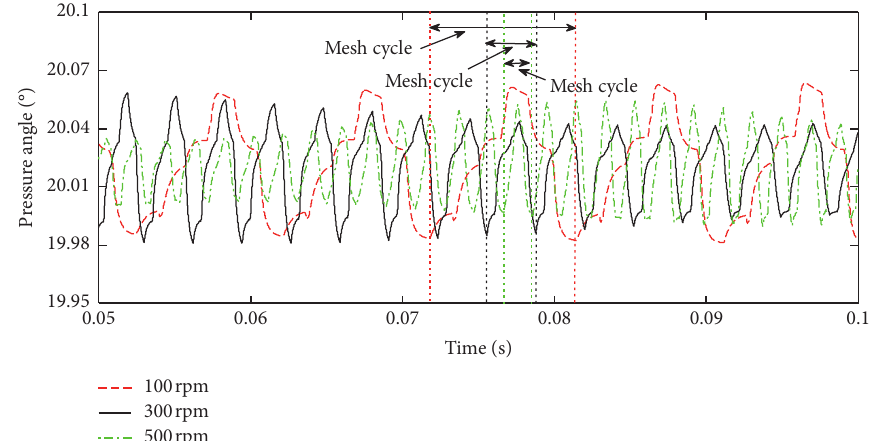
Figure 20: Pressure angle of s- p